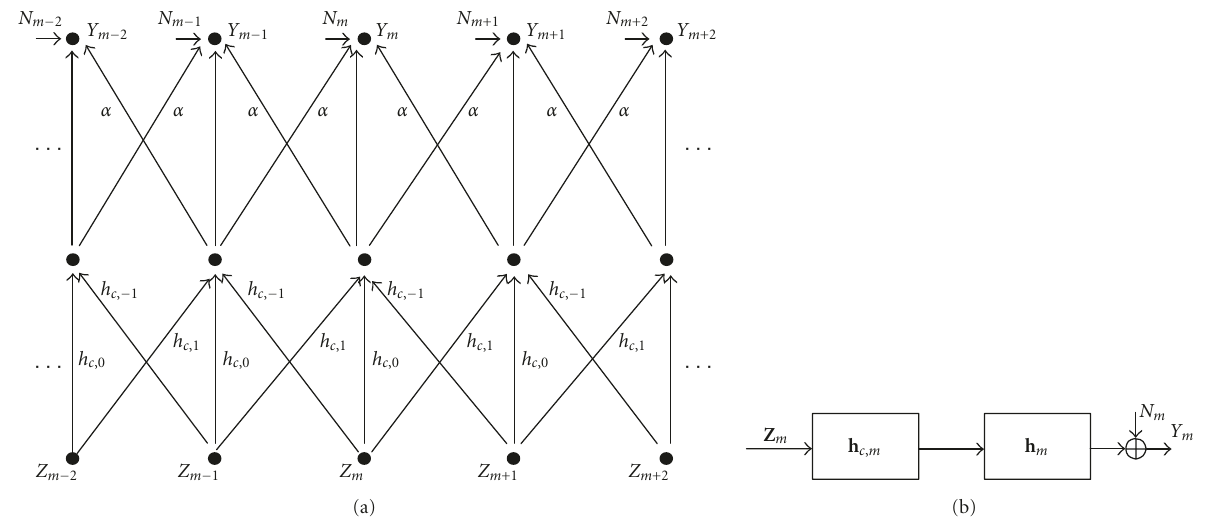
Figure 3: (a) Equivalent channel seen by the common messages, encoded by symbols Z m , after K rounds of the conference phase ( K = 1), (b) corresponding block